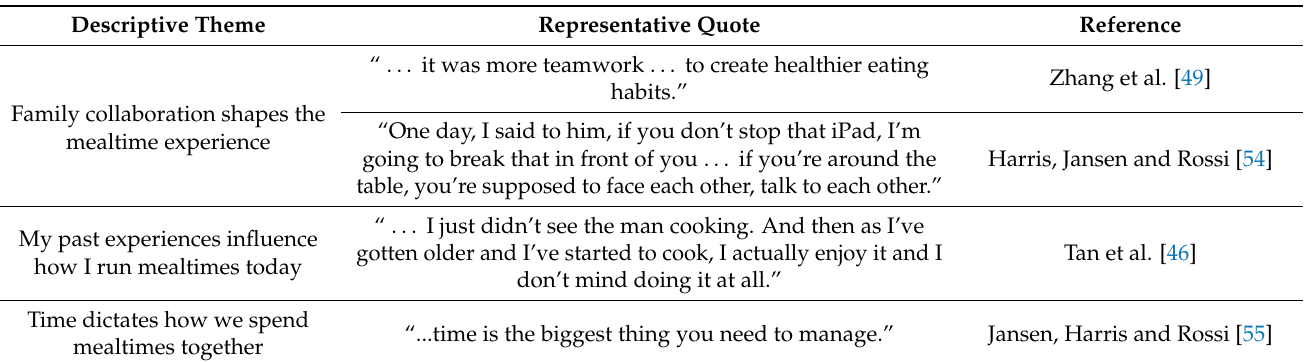
Table 4. Representative quotes for first analytical theme: environmental influences on fathers’ mealtime experiences.